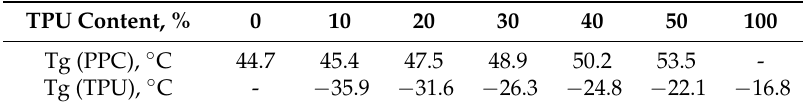
Figure 10. tg δ versus temperature for PPC, TPU and PPC/TPU blends: ( a ) higher temperature, ( b ) lower temperature. Table 2. Glass transition temperature for PPC, TPU and their blends from dynamic mechanical analysis (DMA). TPU Content,